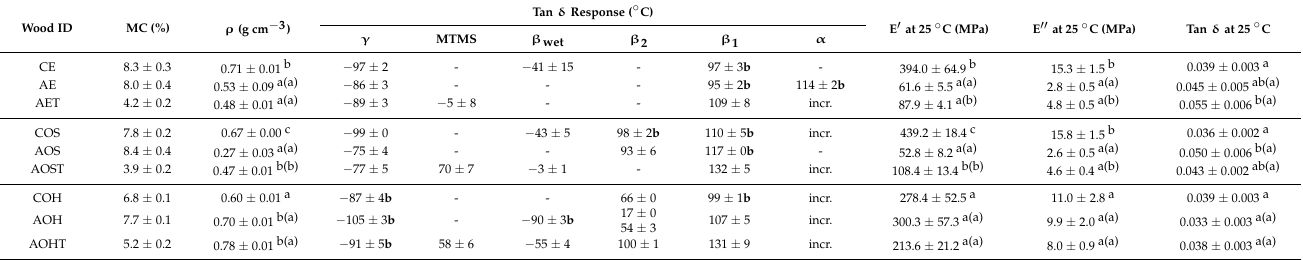
b —broad peak, in some runs divided into two more or less separated peaks; incr.—the curve increases at higher temperatures, indicating a peak at temperatures higher than 150 ◦ C; different superscripts ( a,b ) denote statistically significant ( p < 0.05) differences among mean values within particular wood type groups (elm, oak sapwood, oak heartwood) according to Tukey’s HSD test: the first value relates to comparison between contemporary, archaeological untreated and treated wood, the second value (in brackets) relates to comparison between untreated and treated archaeological